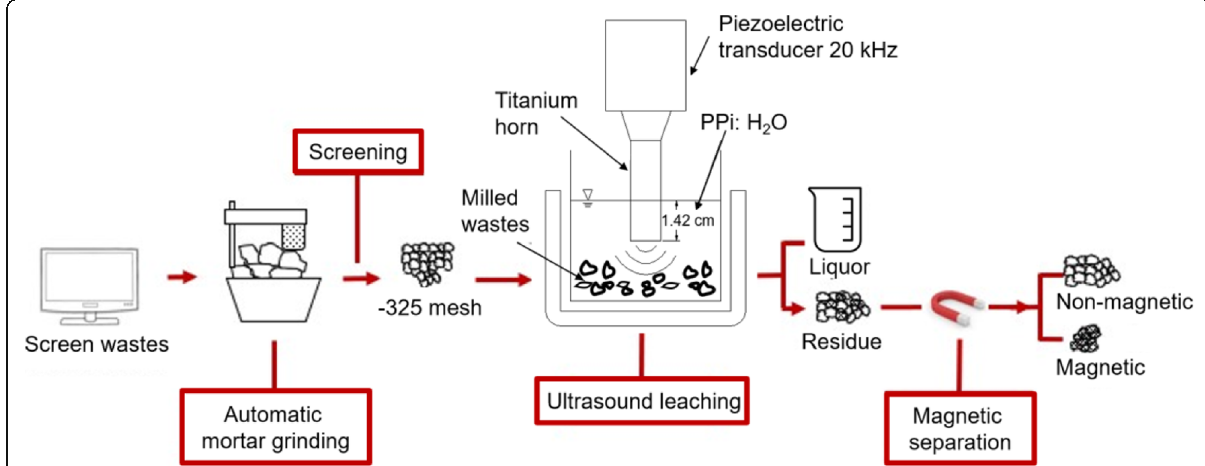
Fig. 1 Experimental scheme of ultrasound-assisted leaching of REE from LCD